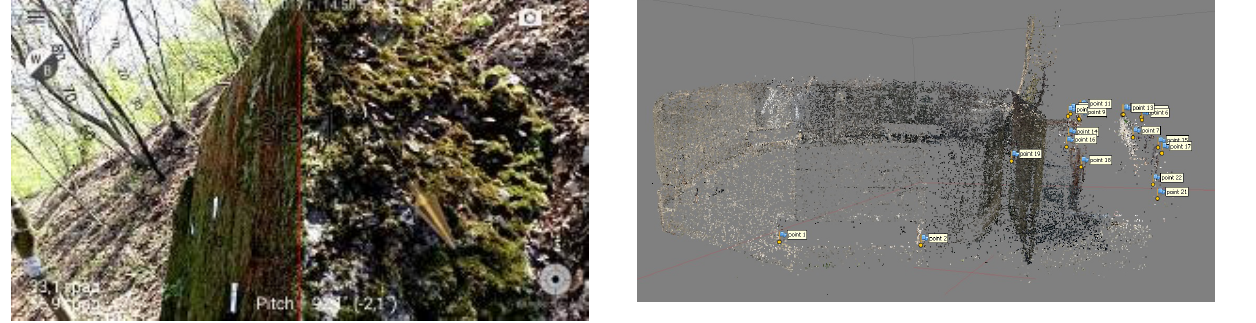
Figure 12. Point cloud of pillbox № 428 with trench